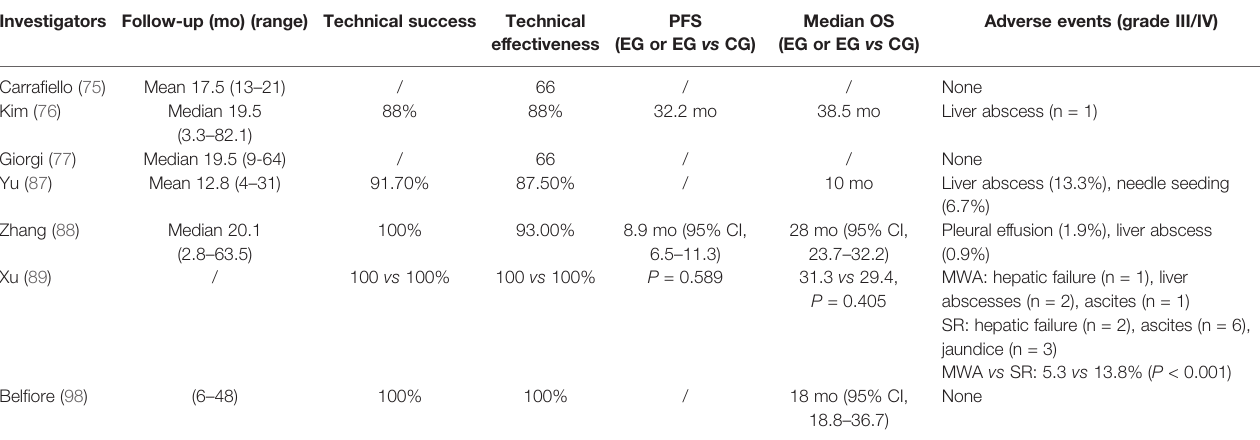
TABLE 4 | Results and adverse events within included studies for ablation. Investigators Follow-up (mo) (range) Technical